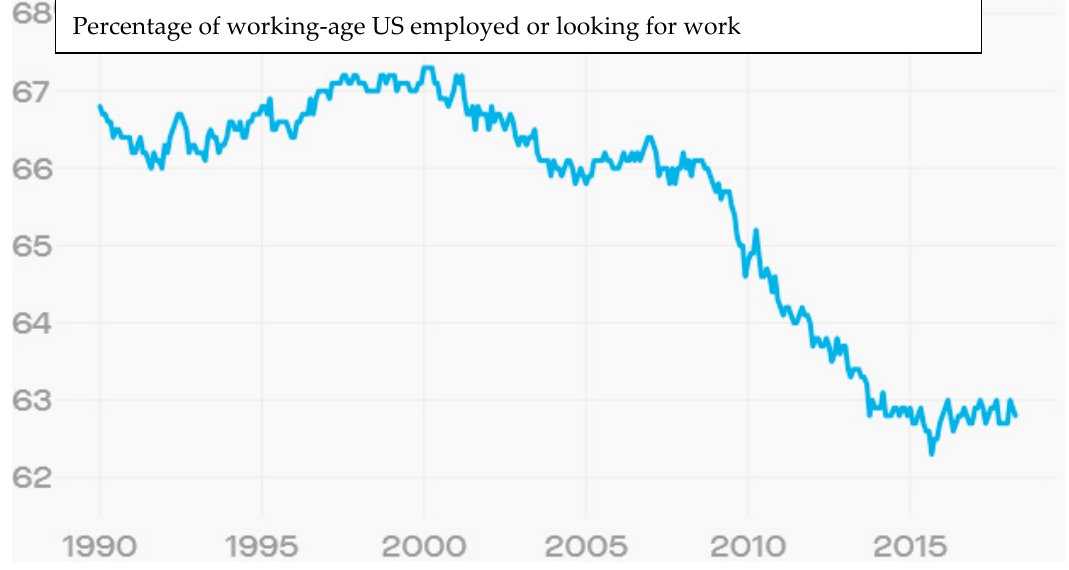
Figure 2. Percent of working-age Americans employed or looking for work. Source: BLS.